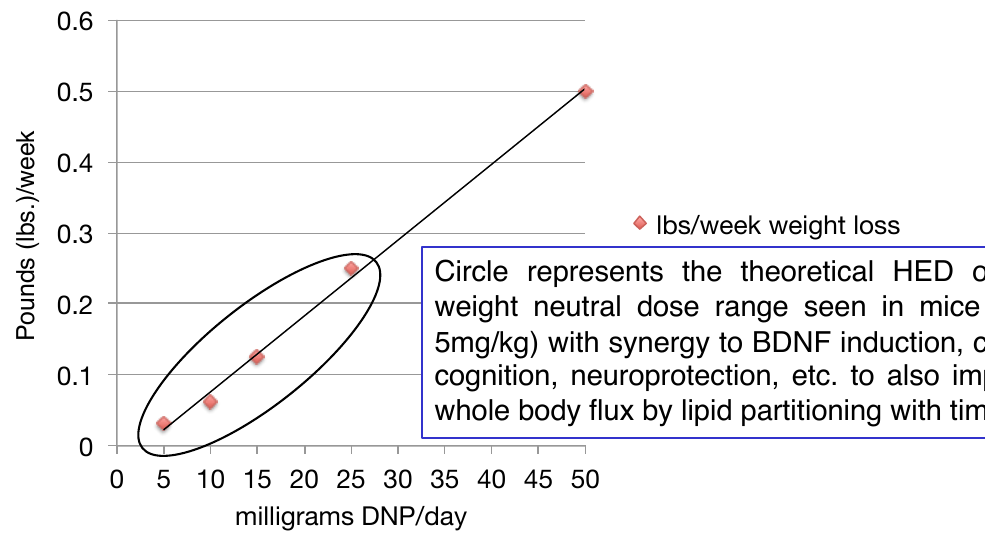
Figure 8. Paradigm shift from weight loss program to a wellness program. Extrapolating the human published data from the 1930s to doses that are significantly lower and likely within the hormetic range of inducing BDNF to gain synergy, while simultaneously partitioning lipids out of insulin-sensitive tissues at weight neutral doses. Human equivalent dose (HED) within this range offers the possibility to significantly improve whole body flux at safe doses using time as the primary